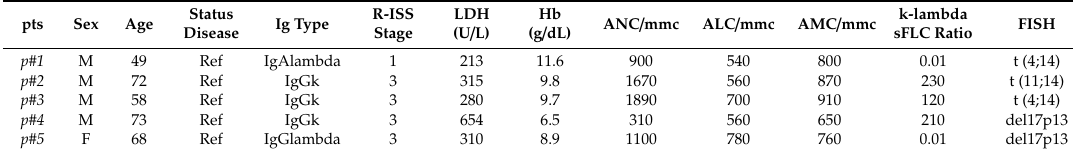
Table 1. Clinical characteristics of patients (pts) included in the study. Ref: refractory to BTZ and lenalidomide